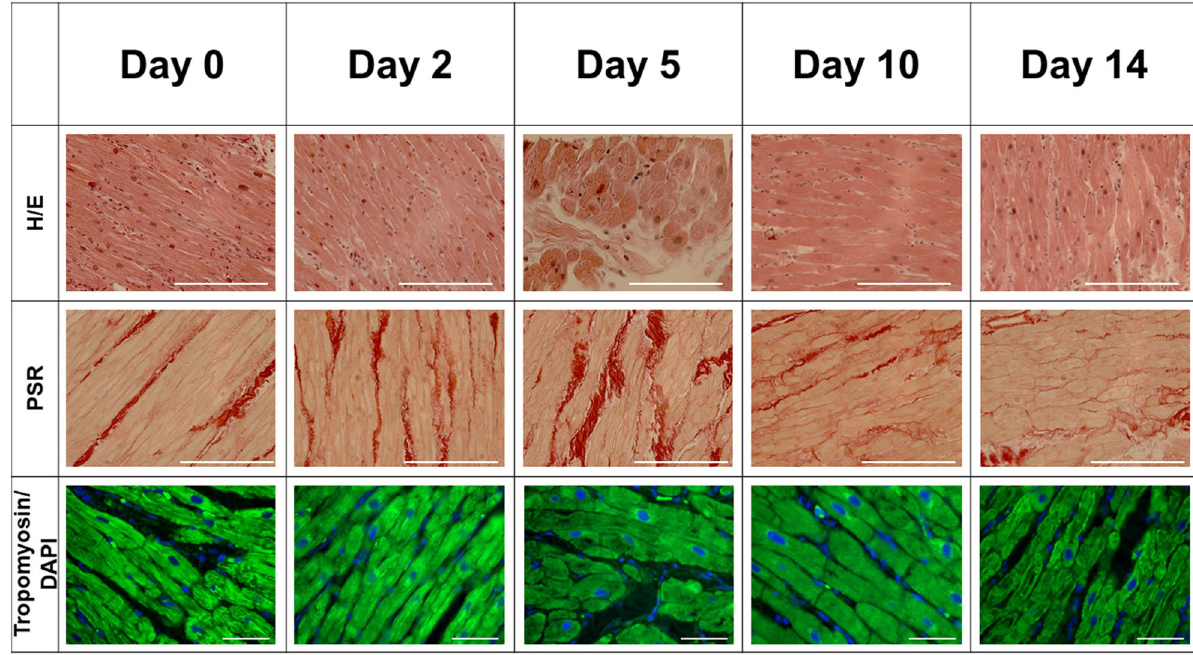
Figure 3. Microscopical images of LMS during various stages of two-week cultivation. LMS derived from the same sample obtained from the same patient, yet different layers of the atrial wall. Scale bar = 100